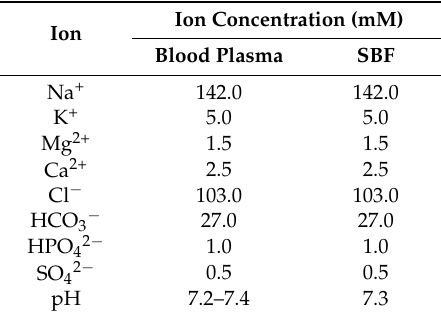
Table 2. The concentrations of various ions in the